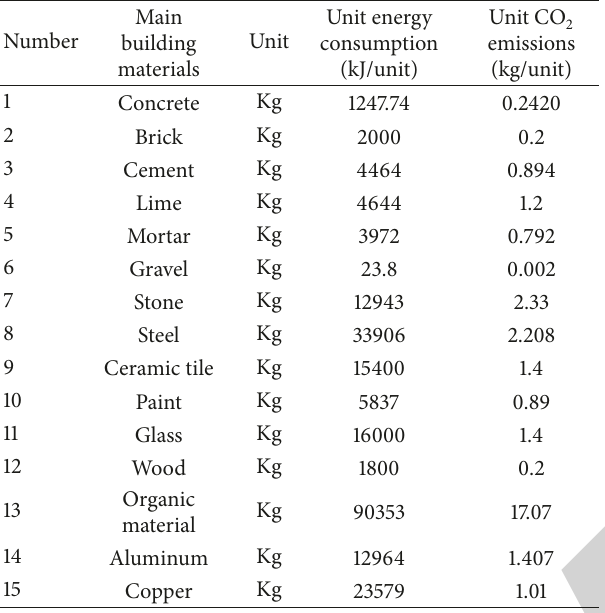
Table 2: The data of unit energy consumption and unit CO emissions generated by the main building material production.